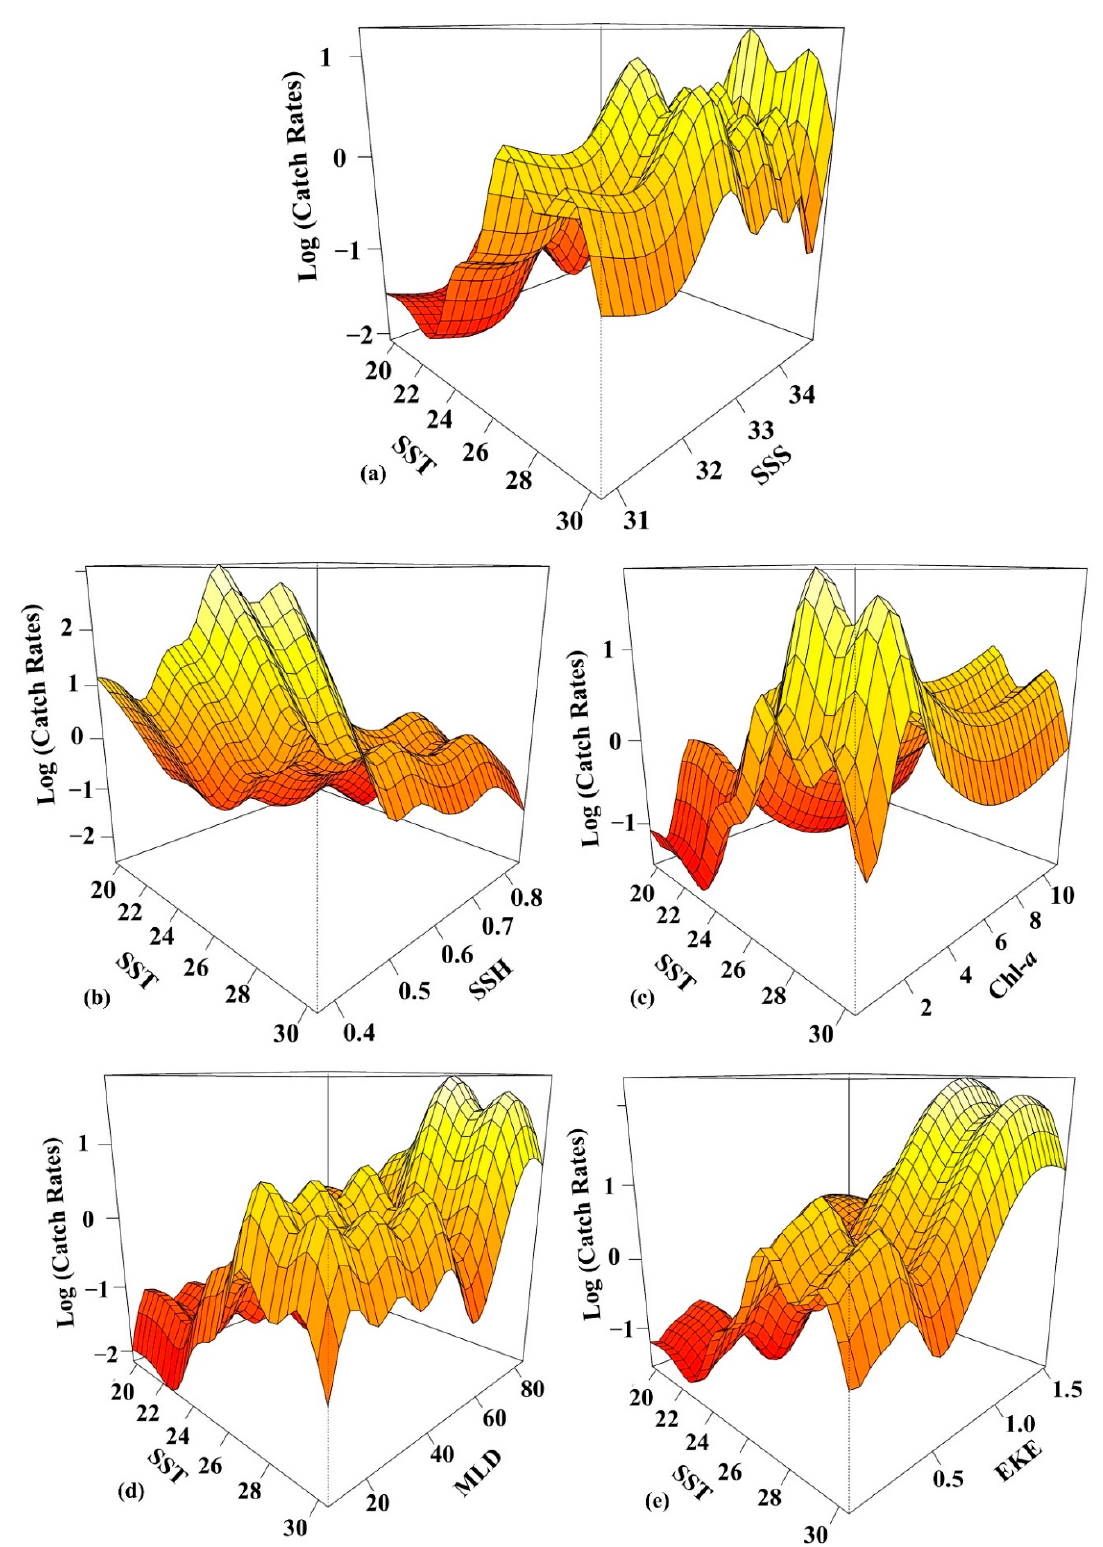
Figure 7. Three-dimensional partial dependence plots representing the environmental variables with Log (Catch Rates) in the interaction between the ( a ) SST and SSS; ( b ) SST and SSH; ( c ) SST and Chl- a ; ( d ) SST and MLD; ( e ) SST and EKE in the model.